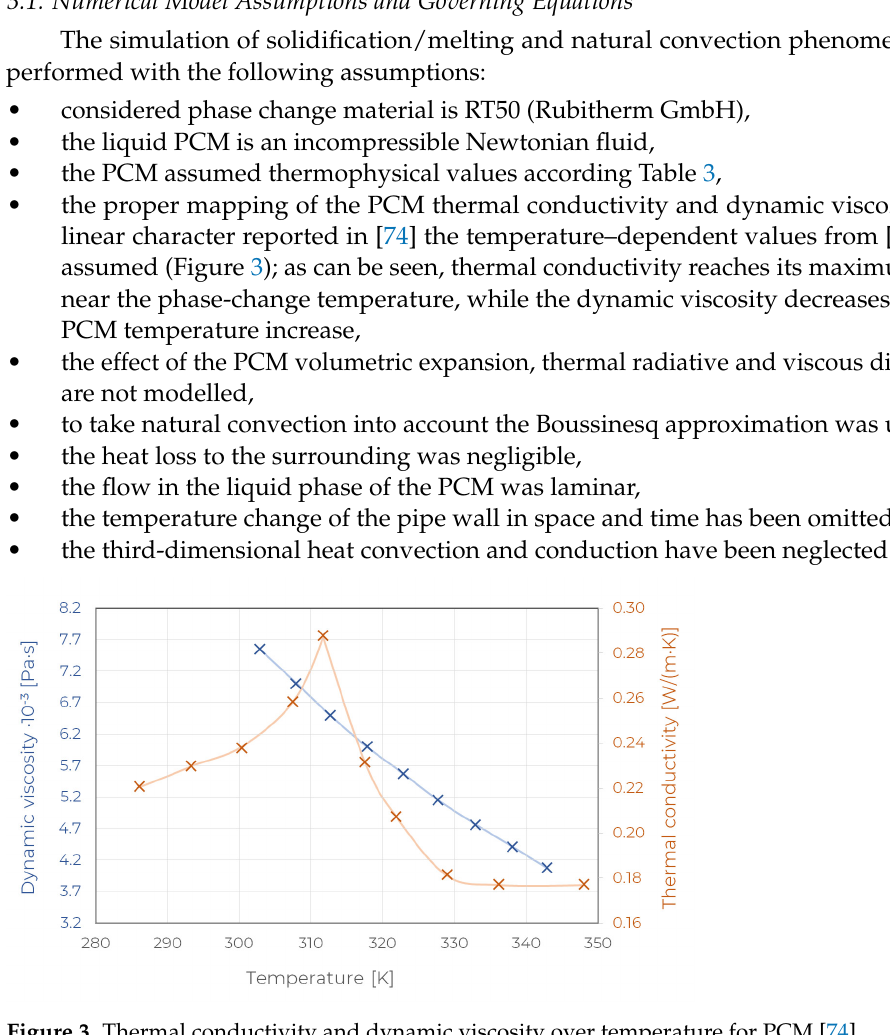
Figure 3. Thermal conductivity and dynamic viscosity over temperature for PCM [74]. Table 3. Thermophysical properties of PCM (RT50)